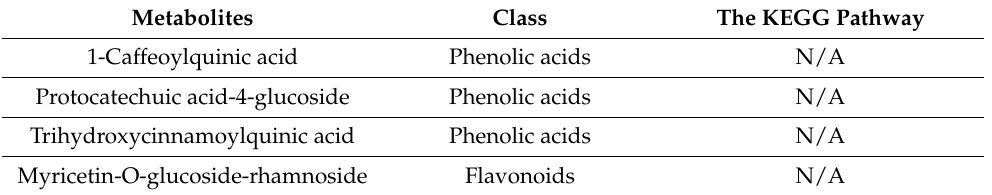
Table 3. KEGG pathway of four mobile metabolites related to early-maturity traits in potato plants.